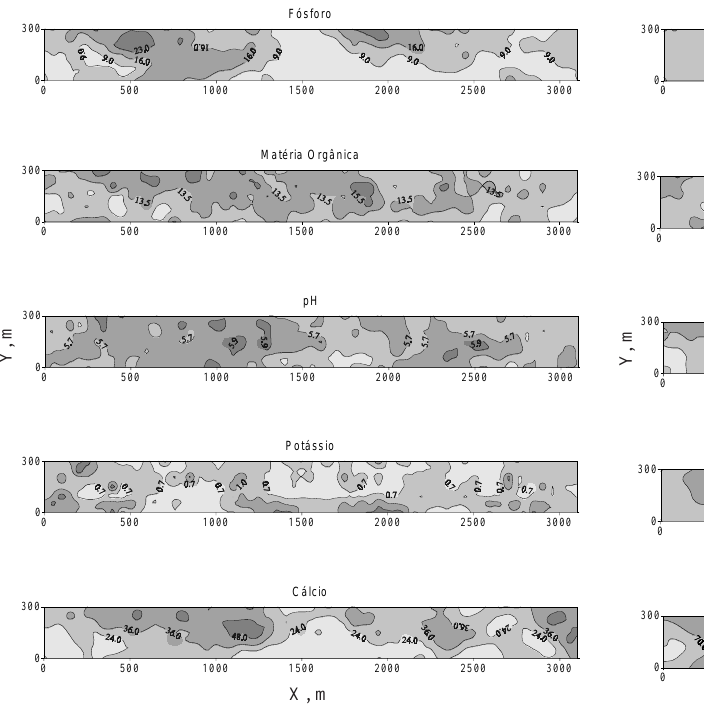
Figura 3. Mapas de isolinhas dos atributos P, MO, pH, K + e Ca 2+ , na profundidade de 0,60–0,80 m.